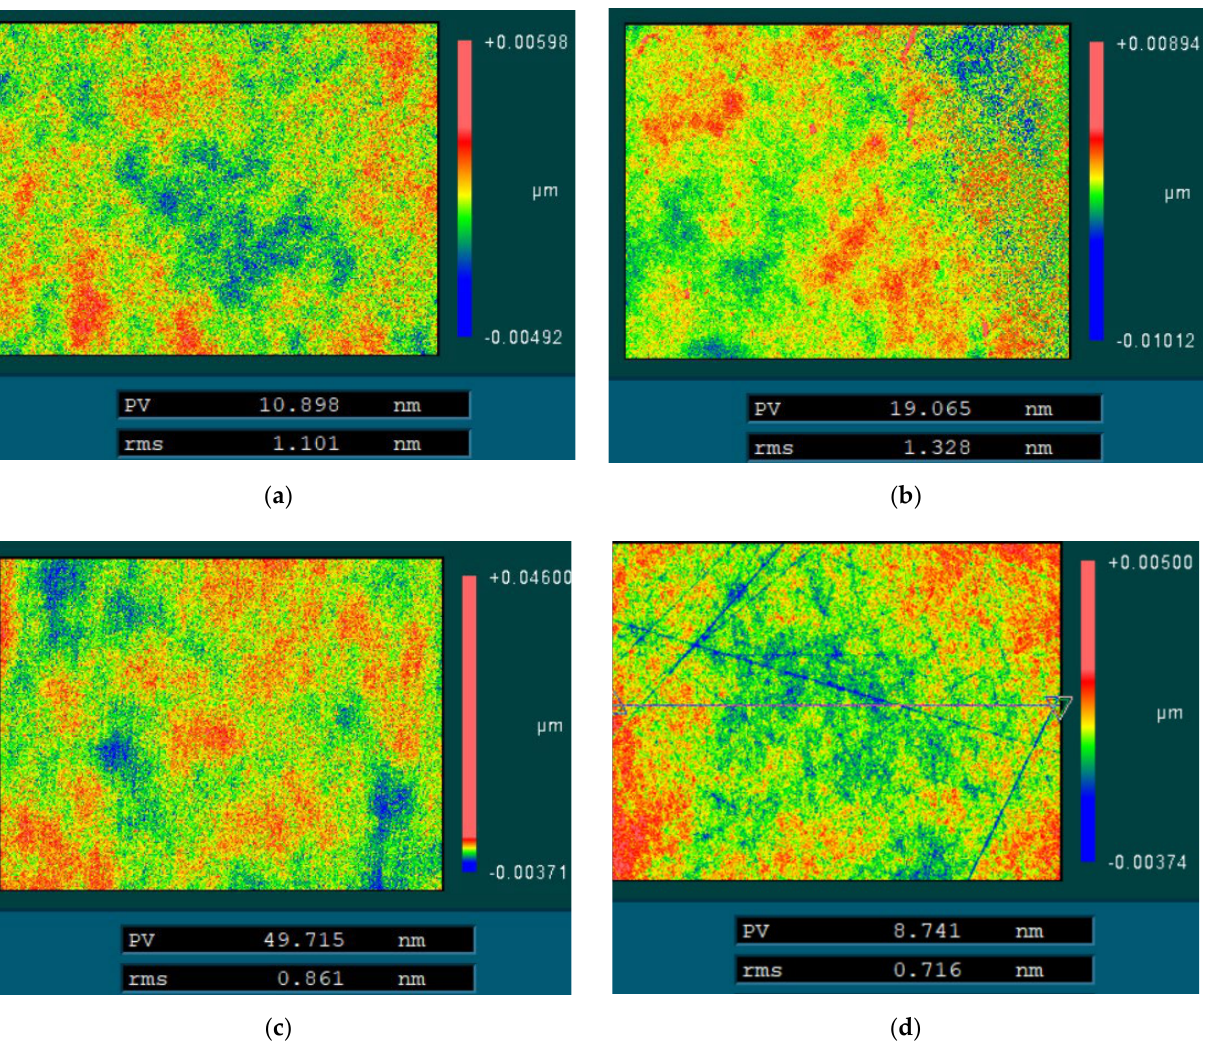
Figure 10. Test results of surface roughness before and after pickling and magnetorheological polishing. ( a ) Surface Roughness of Initial Components; ( b ) Surface Roughness of Undamaged Area after Pickling; ( c ) Surface Roughness after Magnetorheological Uniform Scanning; ( d ) Surface Roughness of Scratched Area after Pickling.